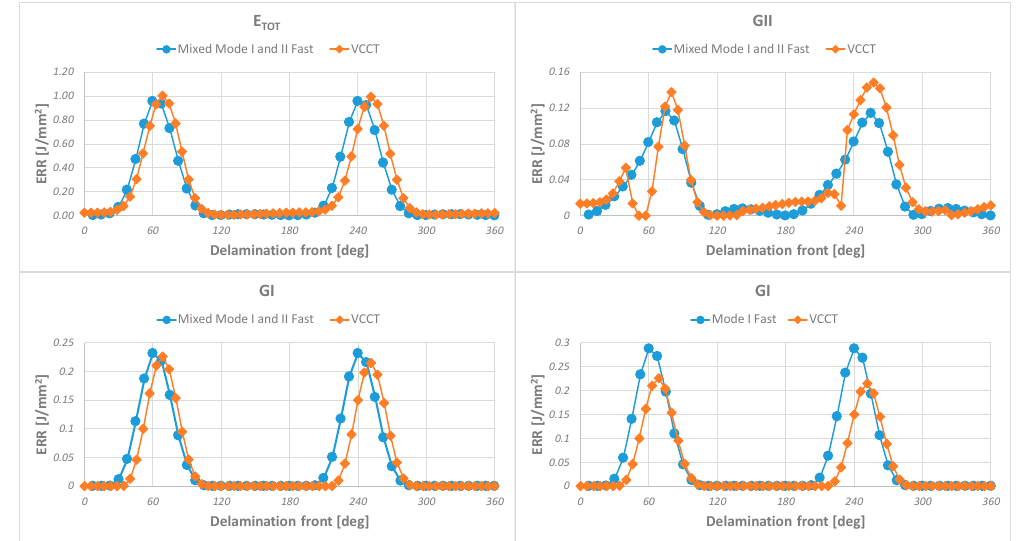
Figure 18. Comparison of SERR distribution for SS#4 damage configuration.